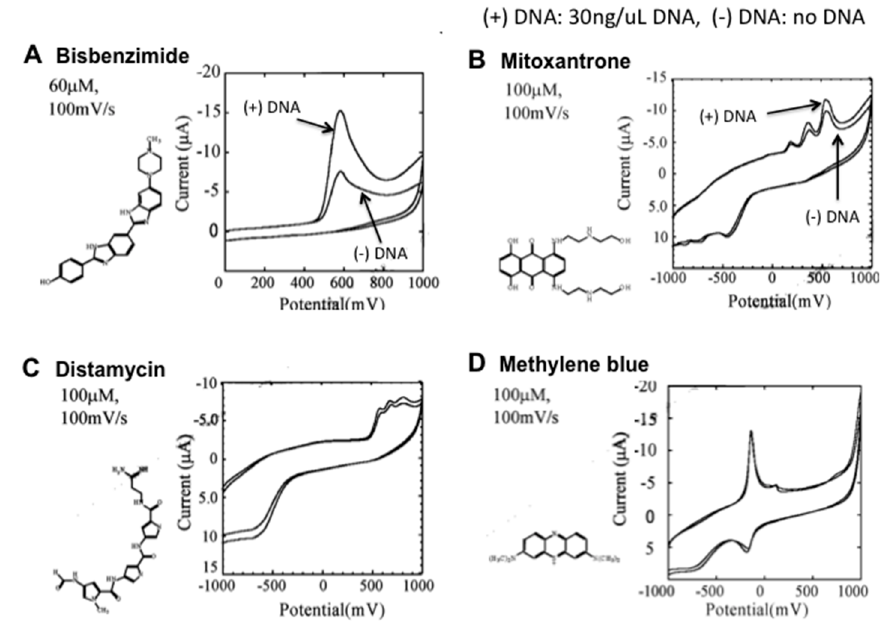
Figure 1. Cyclic voltamograms of various DNA intercalators [51] Hoechst 33258 ( A ); metoxanthrone ( B ); distamycin ( C ); methylene blue ( D ) showing the superiority of Hoescht 33258 as a DNA intercalator, over the other intercalators.